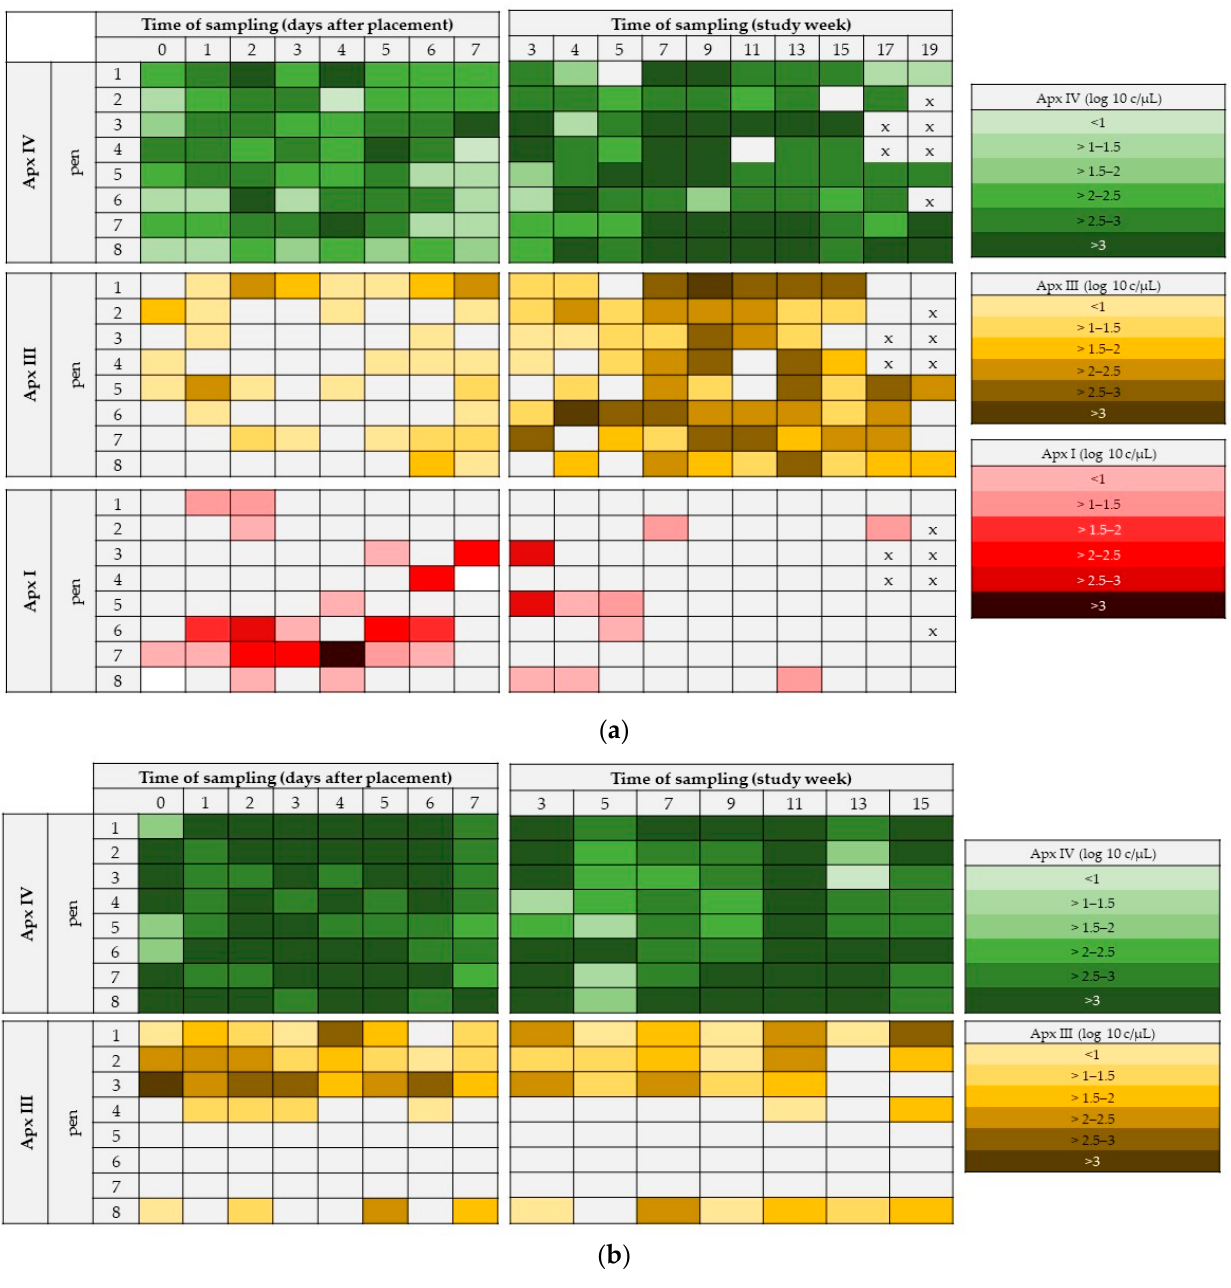
Figure 1. ( a ) Farm A: Apx I-, Apx III-, and Apx I-toxin DNA positive pens within the first week after placement and the entire study period. Different colored squares indicate different DNA-loads in the OFs. All pigs on farm A were vaccinated against A. pleuropneumoniae (Porcilis ® APP; Intervet Deutschland GmbH; Unterschleissheim; Germany) at day 0 after placement and 4 weeks after placement. ( b ) Farm B: Apx IV-, and Apx III-toxin DNA positive pens within the first week after placement and the entire study period. Different colored squares indicate different DNA-loads in the OFs. X = no samples collected .